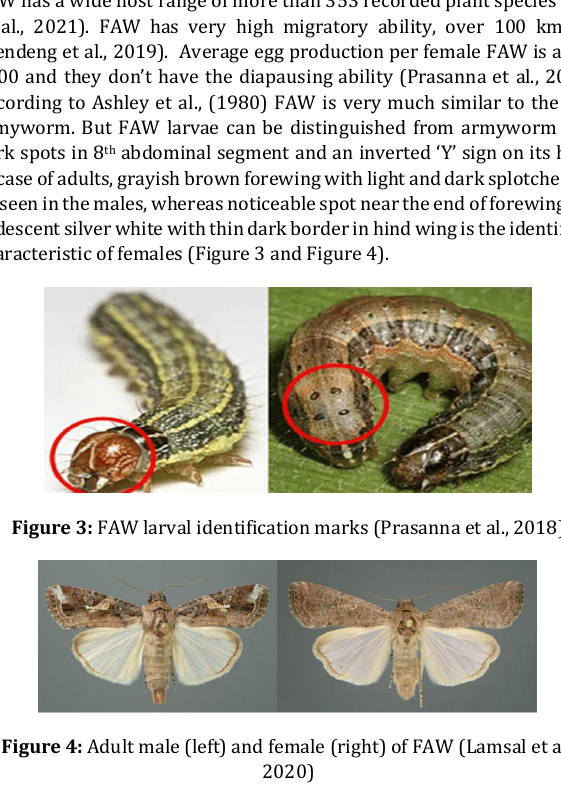
Figure 1: Invasion and outbreak of fall armyworm (FAW) from Africa to AsiabyJing et al., 2021).